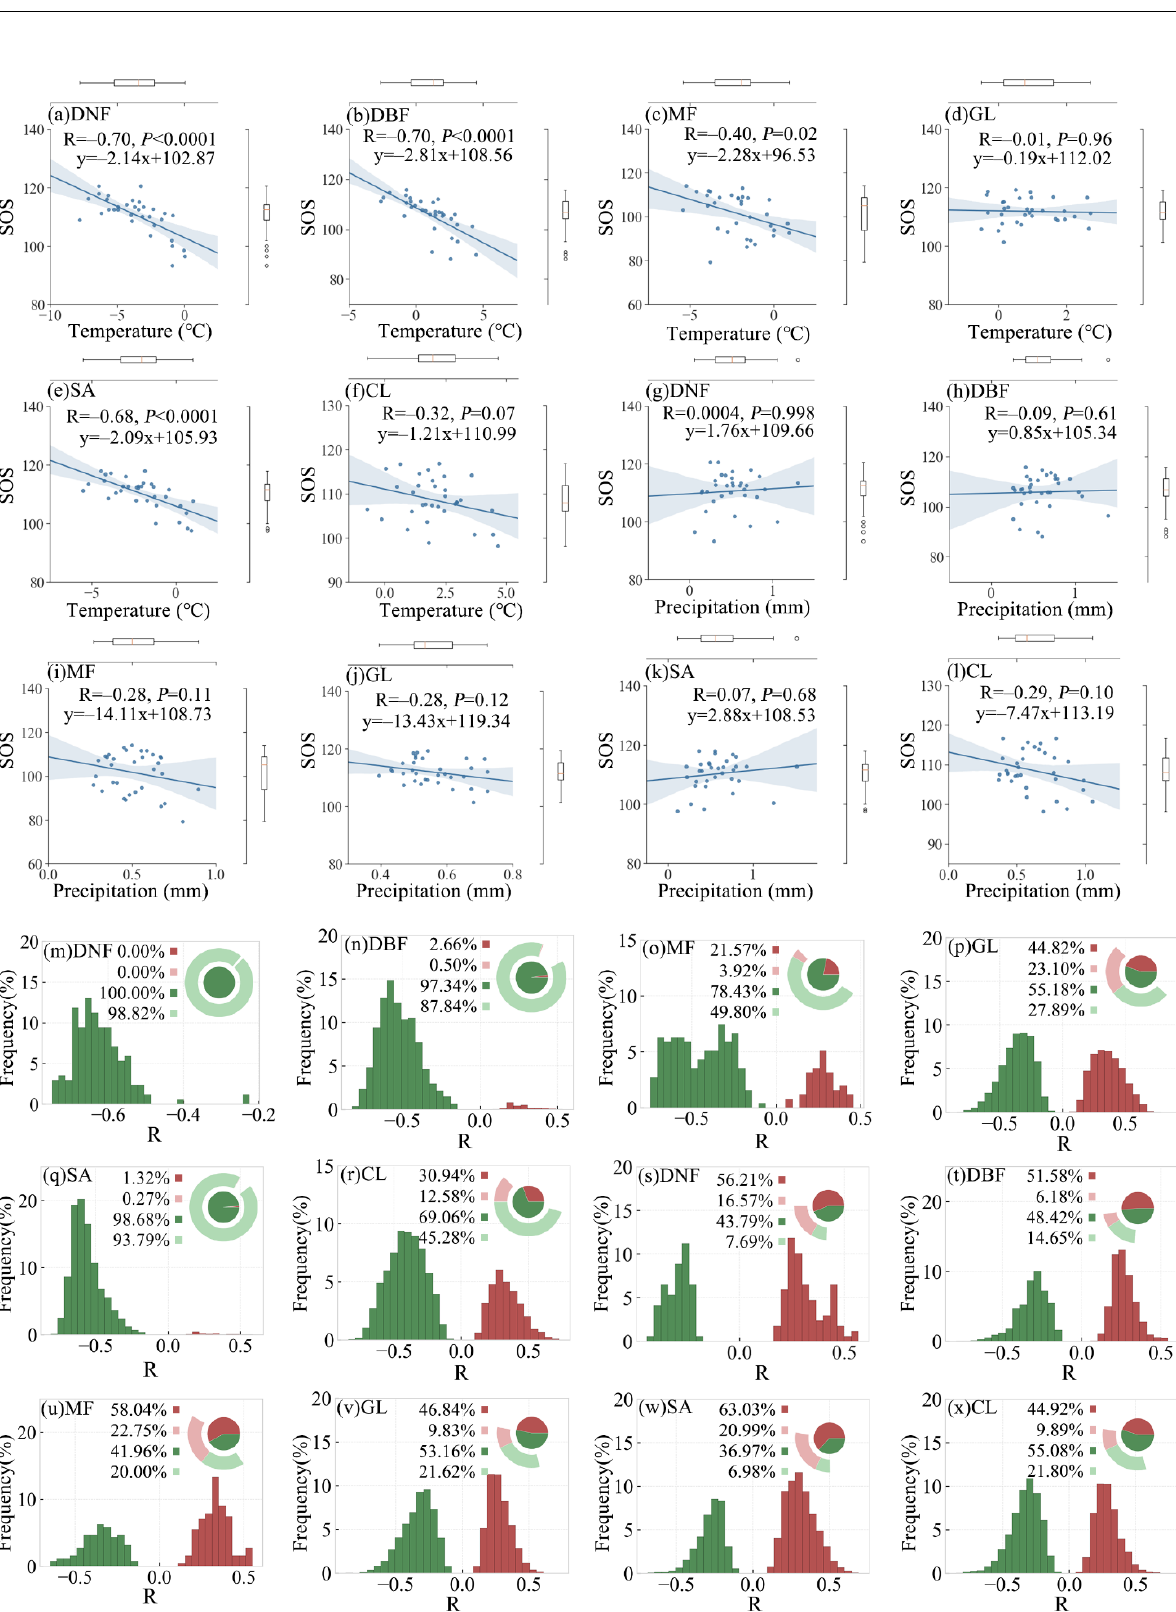
Figure 7. Partial correlogram between preseason temperature ( a – f )/precipitation ( g – l ) and SOS for the various vegetation types, including DNF (deciduous needle leaf forest), DBF (deciduous broadleaf forest), MF (mixed forest), GL (grassland), SA (savanna), CL (cropland). Frequency distribution (%) of the areas with various R values between SOS and preseason temperature ( m – r )/precipitation ( s – x ) for the six vegetation types.